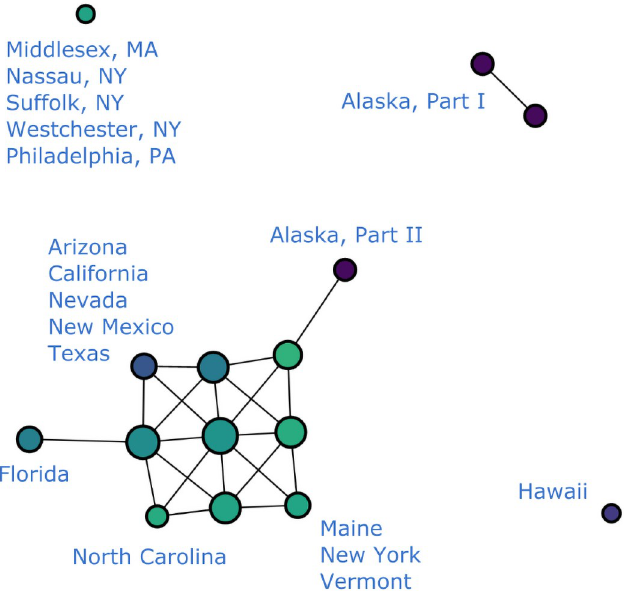
Fig 6. Cumulative COVID-19 cases reported in the U.S. on 7/1/20. ( n = 10, δ = 8%). Note : Alaska, Part I houses the following Alaskan counties: Anchorage, Bethel, Denali, Fairbanks North Star, Kusilvak, Matanuska-Susitna,